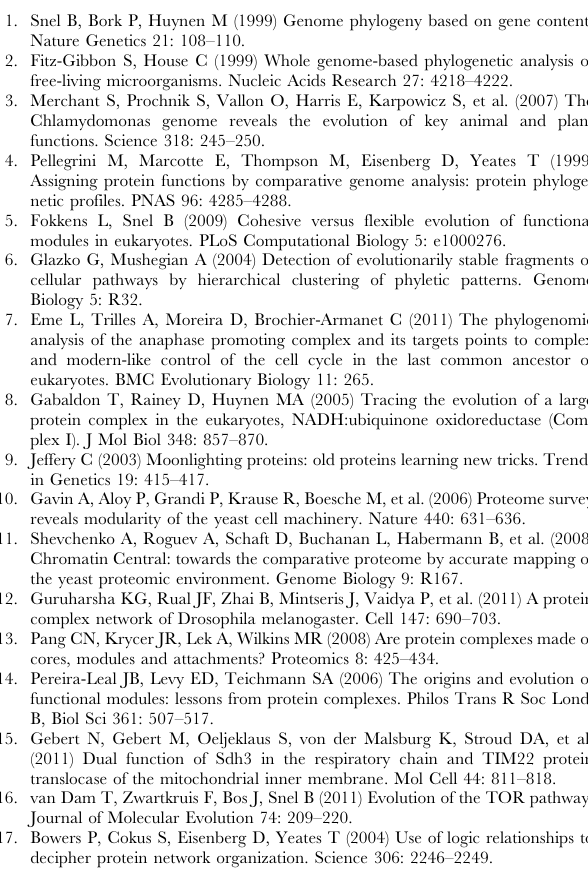
Figure S7 Spearman correlation ( r and p-value) for the fraction of different triangle types over bins for the yeast complexes. Figure S8 Classification of pairwise profiles for the three interaction data sets under different cutoffs using the OMA algorithm. Figure S9 Classification of pairwise profiles for the three interaction data sets under different cutoffs using the MCL algorithm. Table S1 Genomes list. Complete list of all 51 genomes,